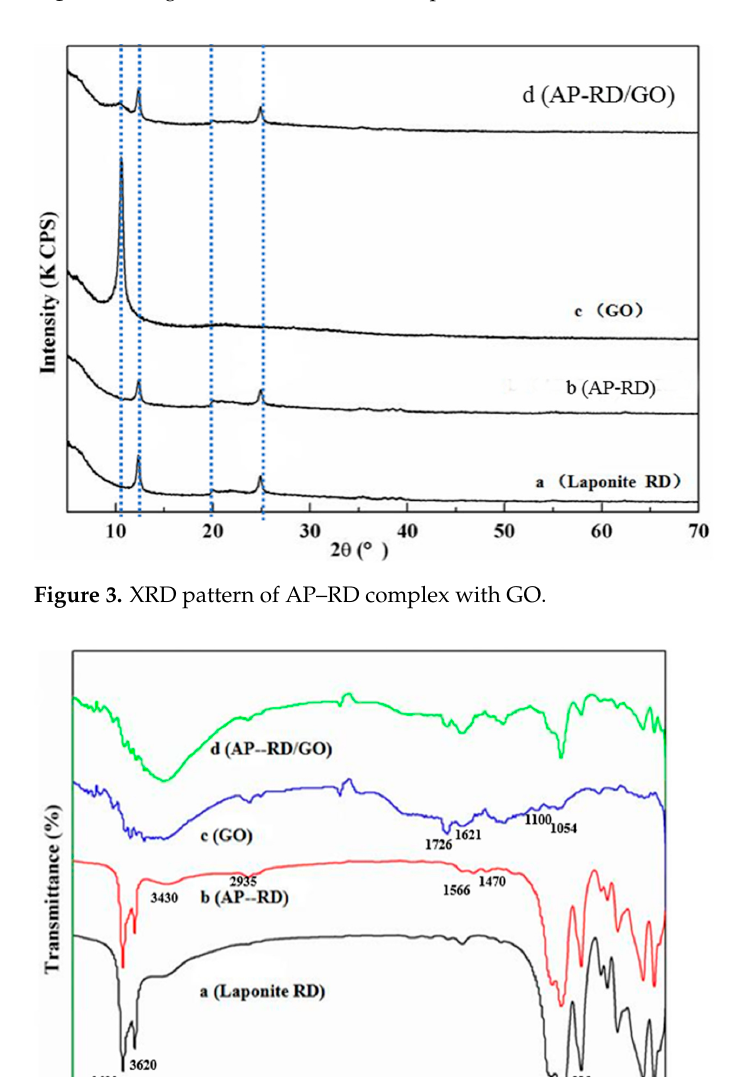
Figure 2. Diagram of modification of Laponite RD.